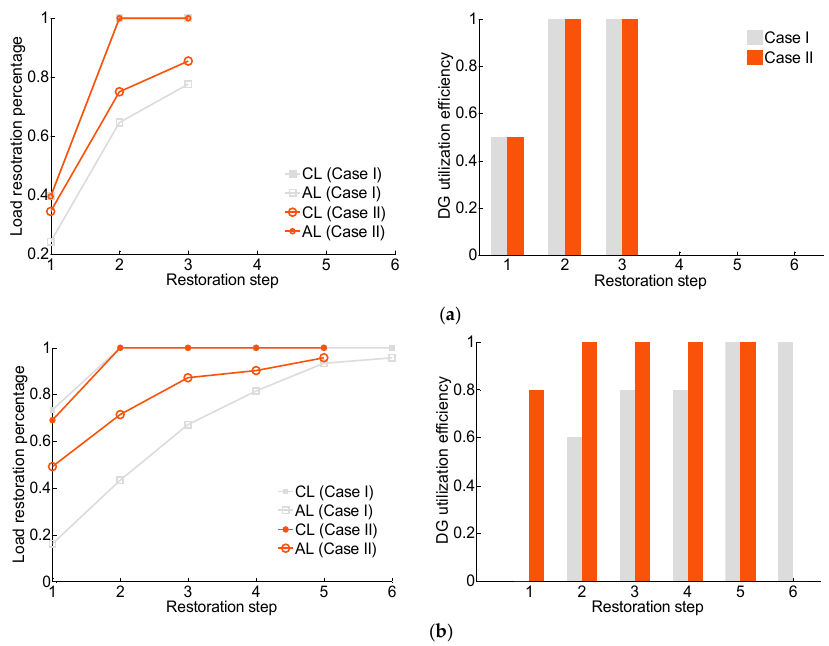
Figure 6. Load restoration percentage (critical (CL) loads and all loads (AL)) and WT utilization efficiency. ( a ) Fault level 20%; and ( b ) Fault level 60%.